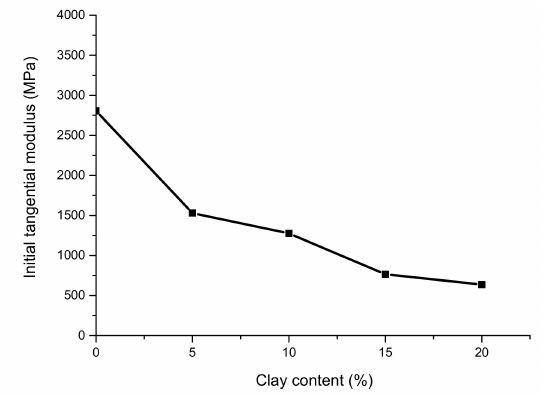
Figure 6. Initial tangential modulus of sediments by clay content